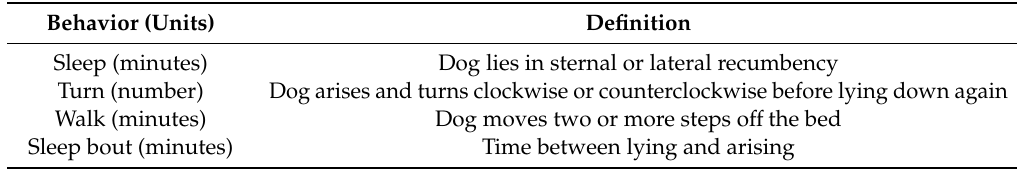
Table 1. Definition of